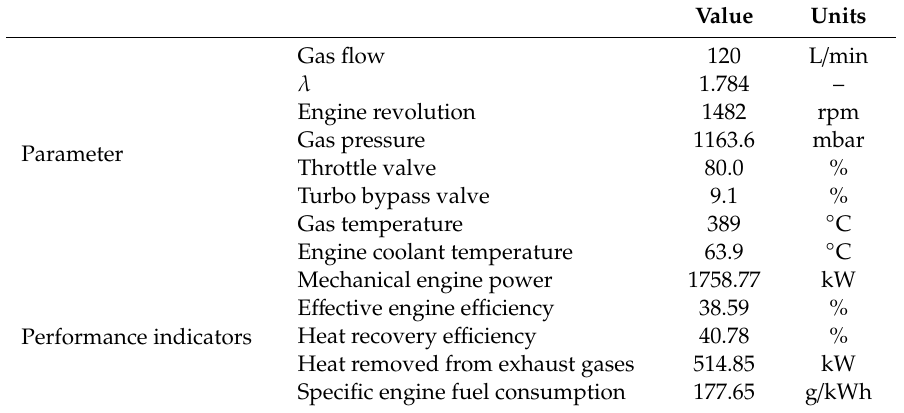
Table 1. Physical engine parameters and internal combustion engine (ICE) performance indicators.